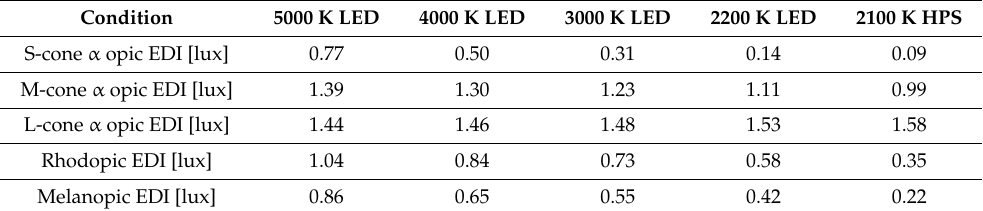
Table 2. Calculated corneal alpha-opic lux values for the five roadway luminaires utilized in the